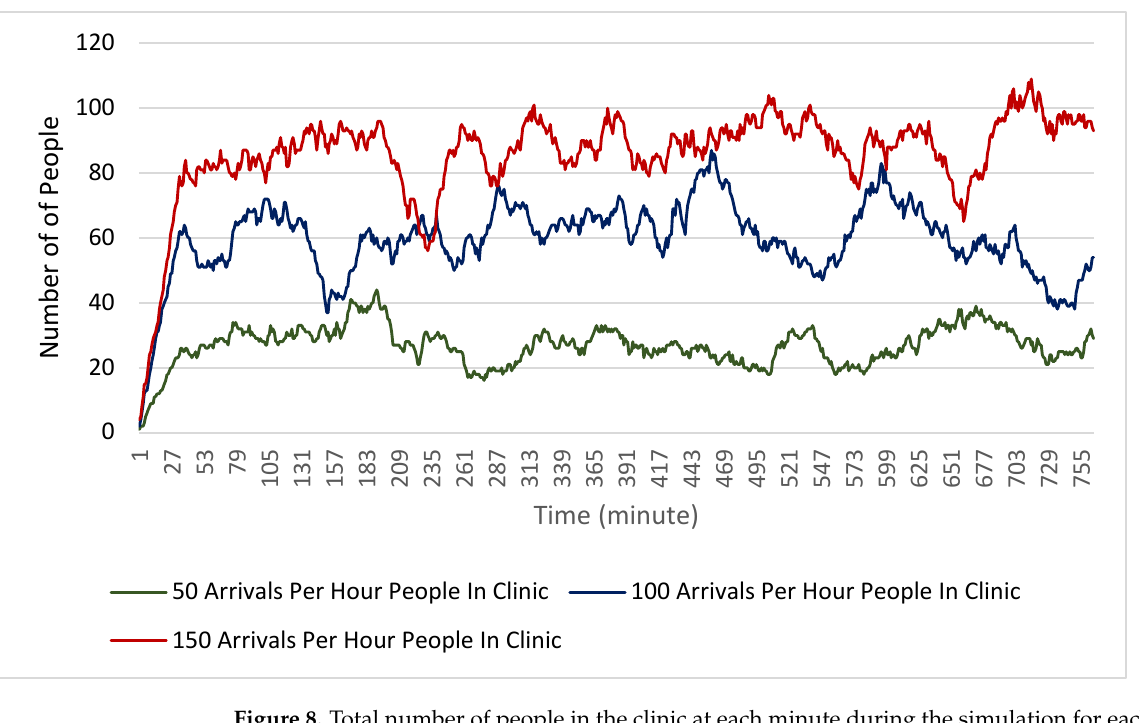
Figure 8. Total number of people in the clinic at each minute during the simulation for each of the arrival rate scenarios with no physical distancing.